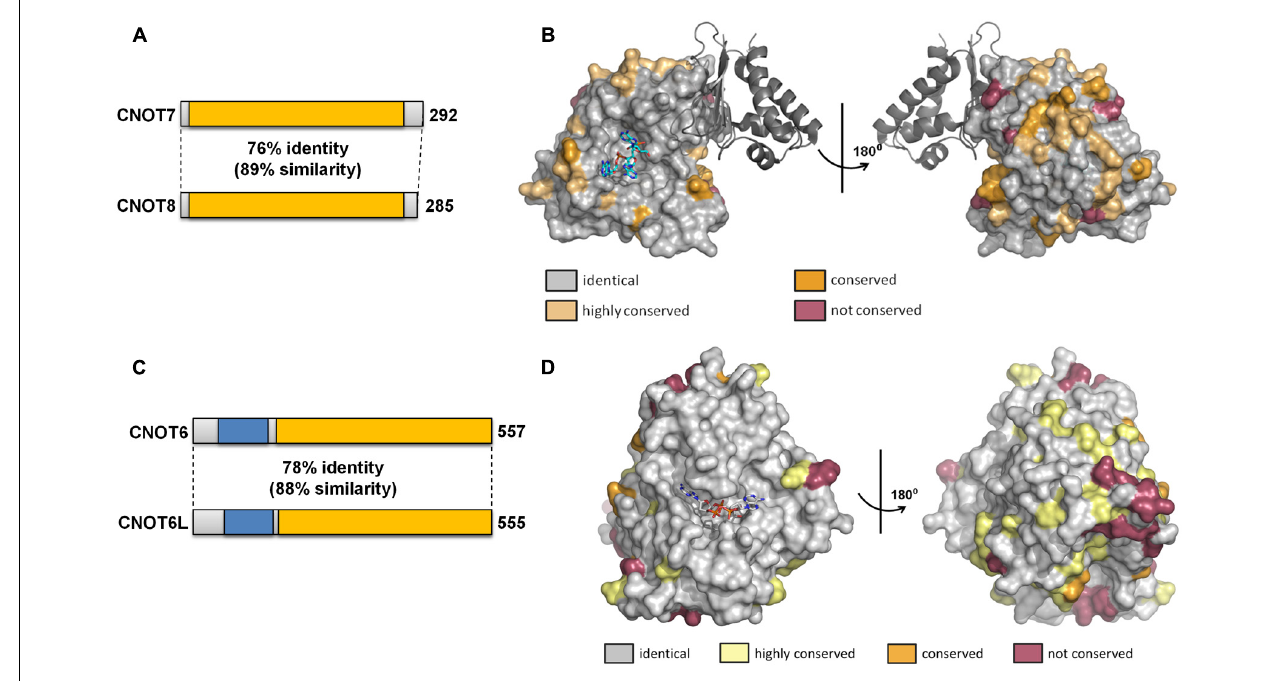
generated using PDB file 2D5R. (C) Schematic overview of similarity between the Ccr4 paralogs encoded by CNOT6 and CNOT6L .The conserved EEP nuclease domain is indicated in yellow, the LRR domain in blue. (D) Conservation of surface residues between the Ccr4/CNOT6 and Ccr4/CNOT6L subunits.The surface of the human Ccr4/CNOT6L protein is shown with residues identical in Ccr4/CNOT6 and Ccr4/CNOT6L shown in gray, conserved residues in tan or dark yellow, and non-conserved residues in purple.The image was